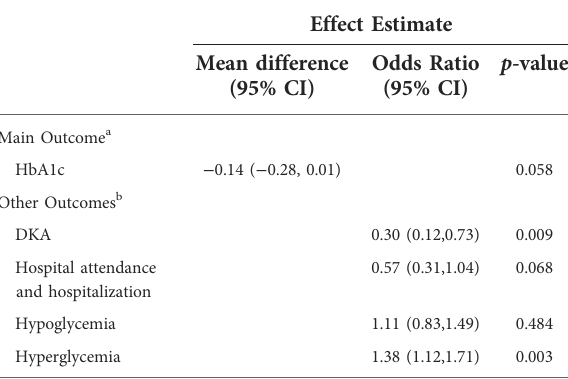
TABLE 2 Glycemic outcomes of study participants. TABLE 3 Changes in diabetes control and diabetes-related morbidities during the COVID-19 pandemic ( n =344).